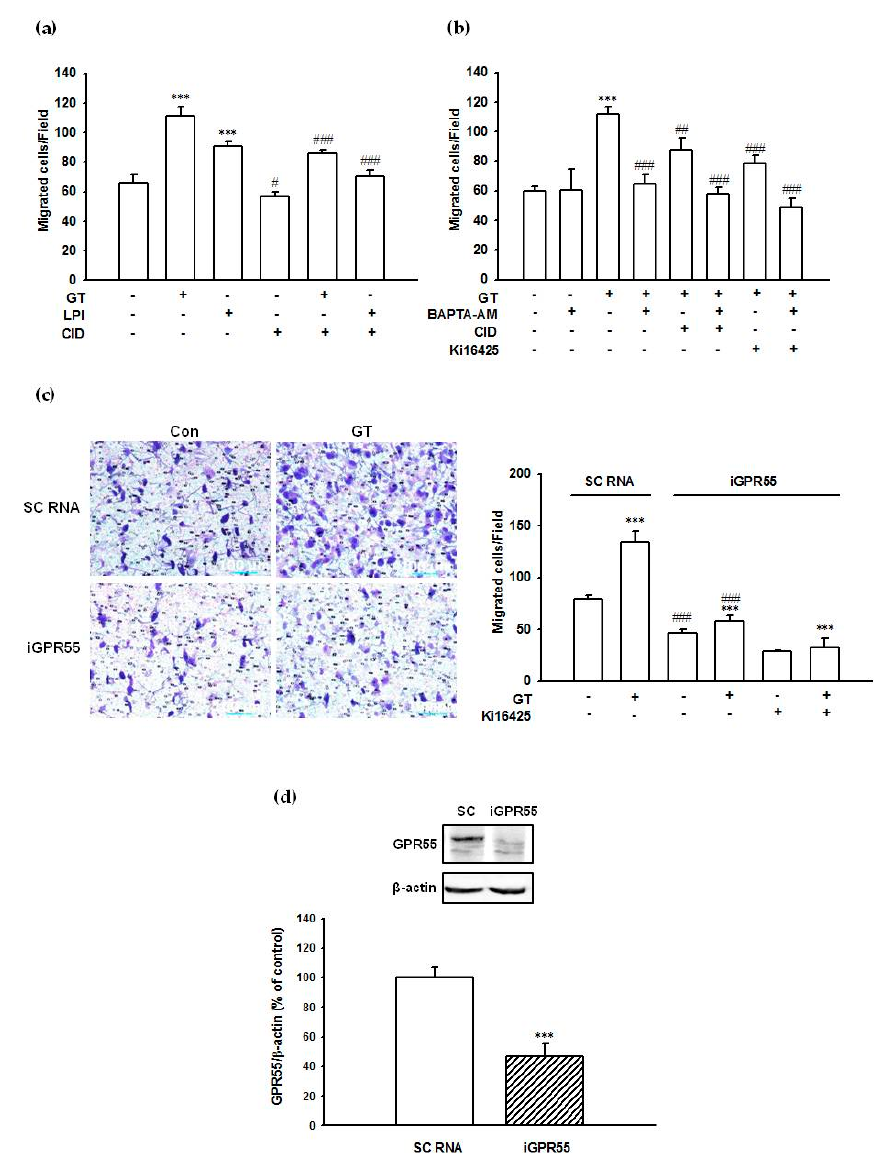
Figure 8. Inhibitory effects of a GPR55 antagonist, a calcium chelator, an LPA1/3 antagonist, and GPR55 silencing via siRNA on gintonin-induced migration and effect of siRNA treatment on GPR55 expression. Cells were incubated with gintonin (1 μ g/mL) or LPI (1 μ M) in serum-free RPMI1640 medium in the presence or absence of the GPR55 antagonist CID16020046 (10 μ M) ( a , b ), the calcium chelator BAPTA (5 μ M) ( b ), or the LPA1/3 antagonist Ki16425 (10 μ M) ( b , c ) for 5 h. The migration of cells towards the gintonin-containing chamber through the polycarbonate membrane of modified Boyden chambers was quantitated, as described in Materials and Methods ( a – c ). Data represent means ± SD ( n = 4); *** p < 0.001, vs. control (Con). # p < 0.05, ## p < 0.01, ### p < 0.001, vs. GT alone. GT, gintonin; LPI, lysophosphatidylinositol; CID, CID16020046 ( a – c ). ( d ) PC-3 cells were transfected with either scrambled siRNA (SC) or GPR55 siRNA (iGPR40) and incubated for 2 days. Immunoblot analysis of GPR55 levels in PC-3 cells that had been transfected with either scrambled siRNA (SC) or GPR55 siRNA. Data represent means ± SD ( n = 4); *** p < 0.001, vs. sc